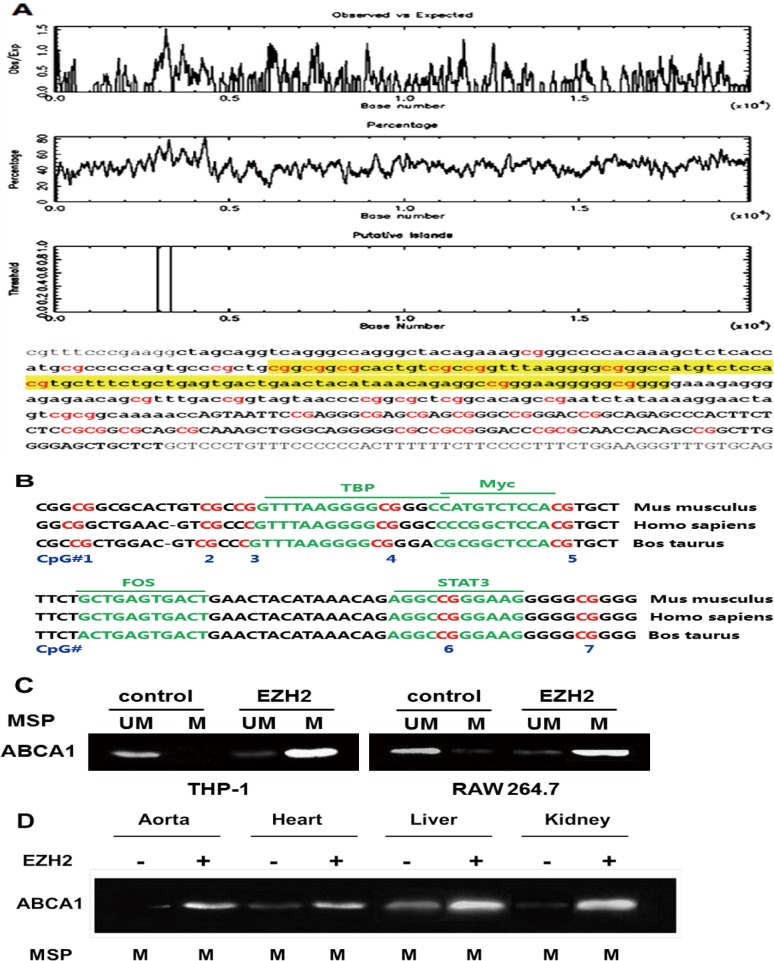
CpG islands identified in ABCA1 promoter sequence are well conserved in evolution and ABCA1 hypermethylation occurs in plaque-laden aorta.A, Observed/Predicted ratio of presence of CpG islands in ABCA1 promoter sequence (highlighted in yellow). Genomic position of promoter and ABCA1 CGIs obtained from different online websites (http://www.ebi.ac.uk/Tools/emboss/cpgplot/ and http://cpgislands.usc.edu/). B, Sequence alignment showing well conserved CpG islands and the binding sites of transcription factors. The conservation of ABCA1 CGI in some mammals obtained from the BLAST of NCBI (http://blast.ncbi.nlm.nih.gov/Blast.cgi?CMD=Web&PAGE_TYPE=BlastHome), and the transcription factor binding site is predicted by JASPAR (http://jaspar.genereg.net/). C, Hypermethylation of ABCA1 promoter in THP-1 and RAW264.7 macrophage-derived foam cells after EZH2 infection. PCR primers specific to unmethylated and methylated bisulfite-modified DNA were used to amplify the promoter of ABCA1 gene after EZH2 treatment. D, ABCA1 promoter methylation of the apoE−/− mouse aorta, heart, liver and kidney was analyzed by MSP. UM: unmethylated; M: methylated.